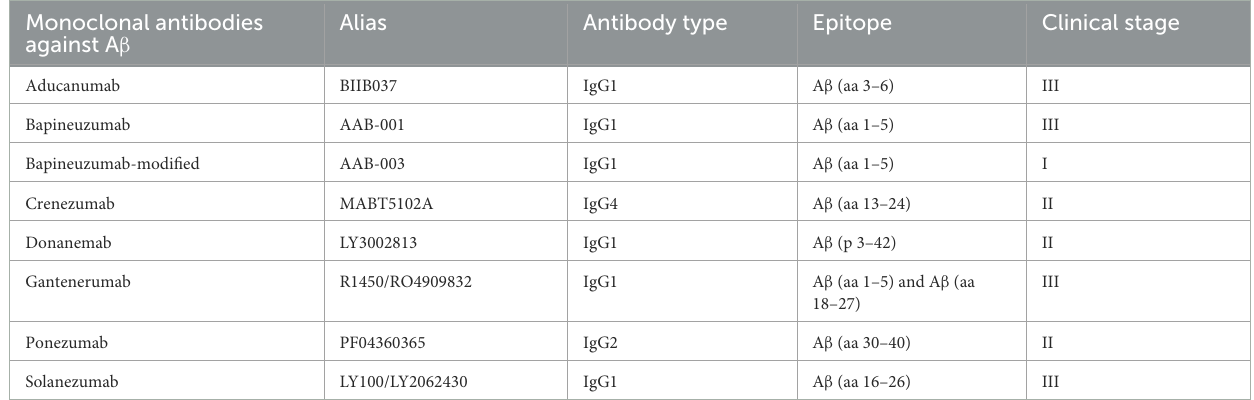
TABLE 2 Major monoclonal antibody immune